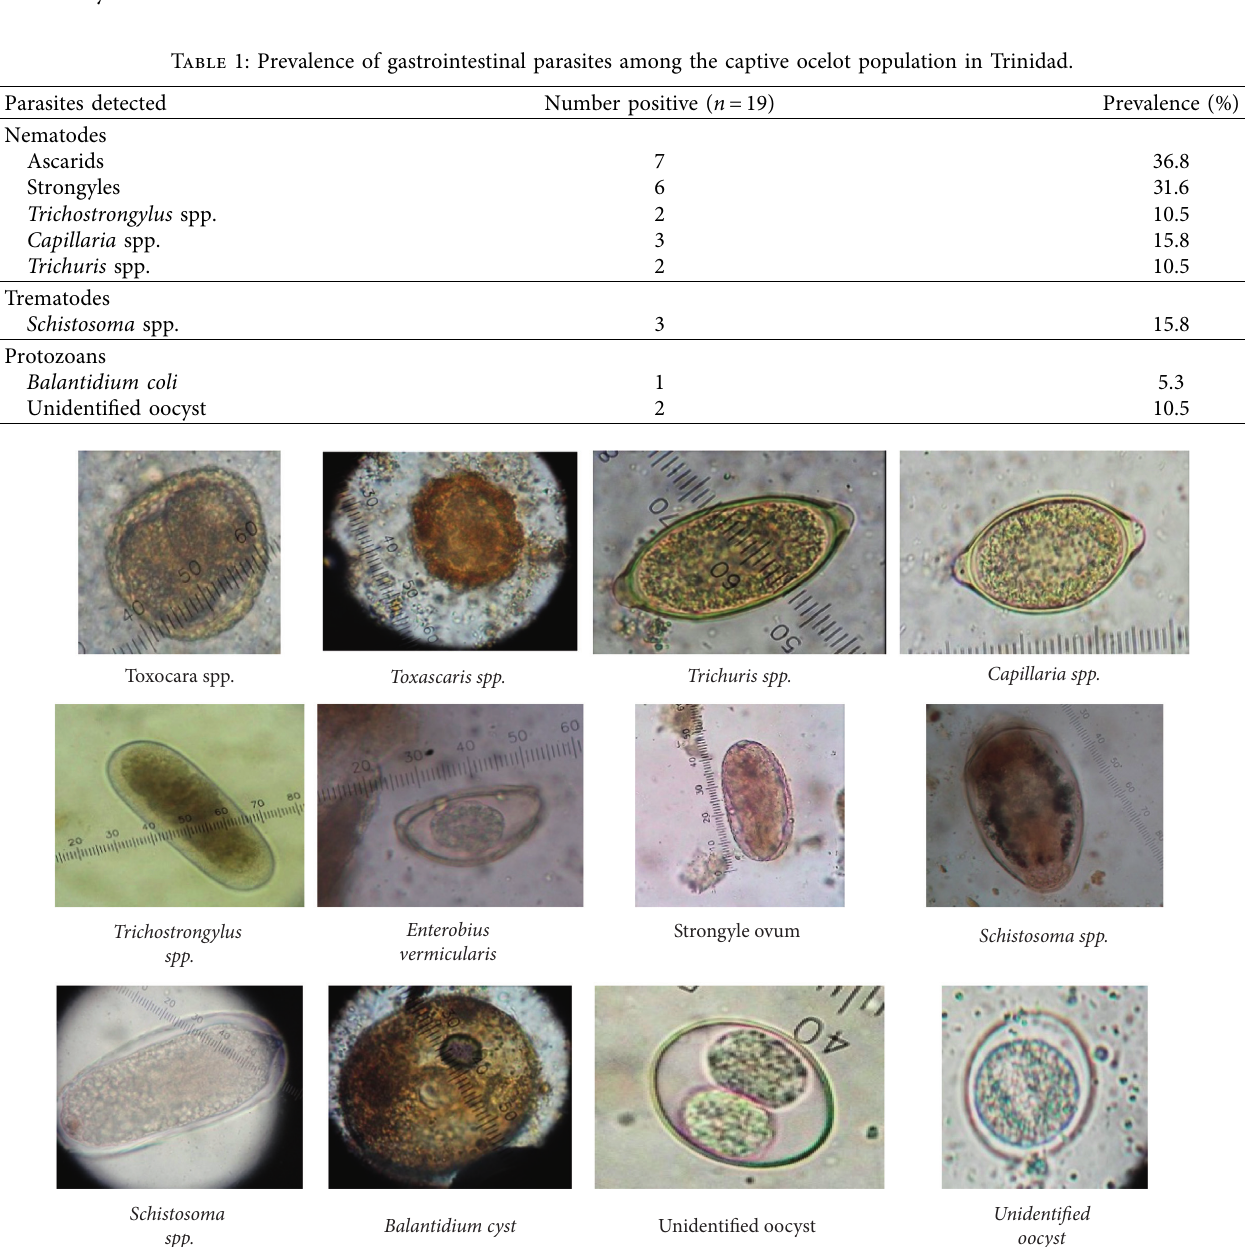
Figure 2: Images of gastrointestinal parasites identified among the captive ocelot population in